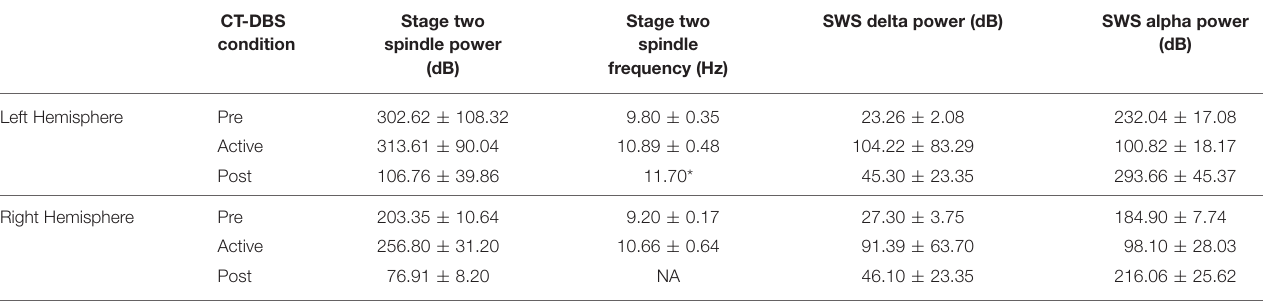
TABLE 1 | Average sleep variables calculated from EEG power spectral